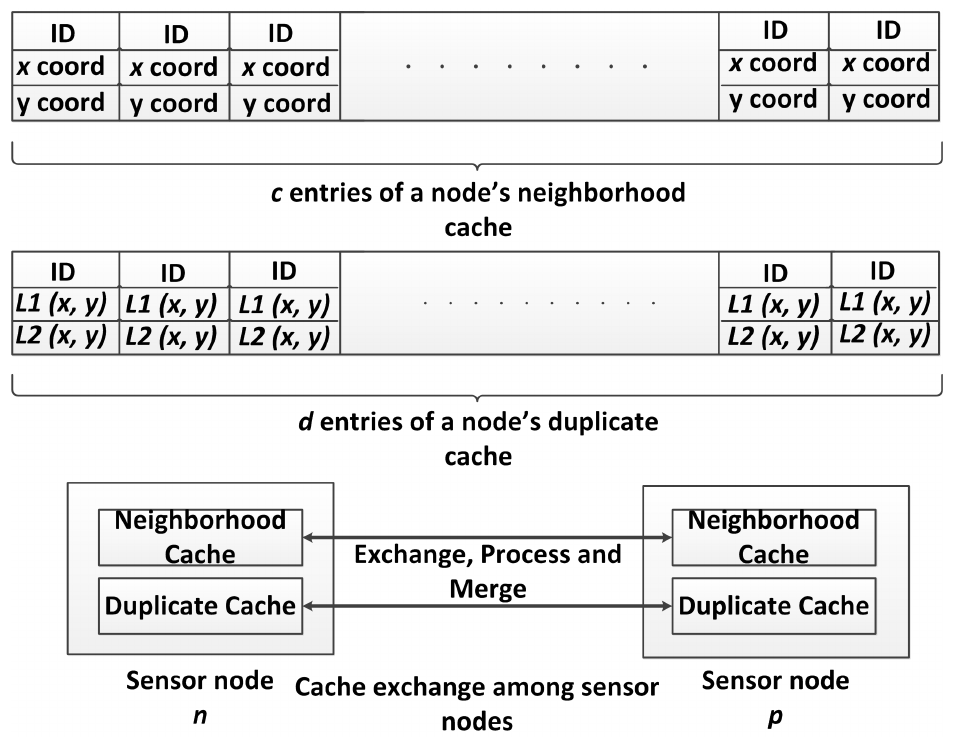
Figure 2. Cache structure and exchange. Note that the duplicate cache only needs to store the identity of the duplicate node and no more than two distinct locations regardless of the number of locations in which the replica has been